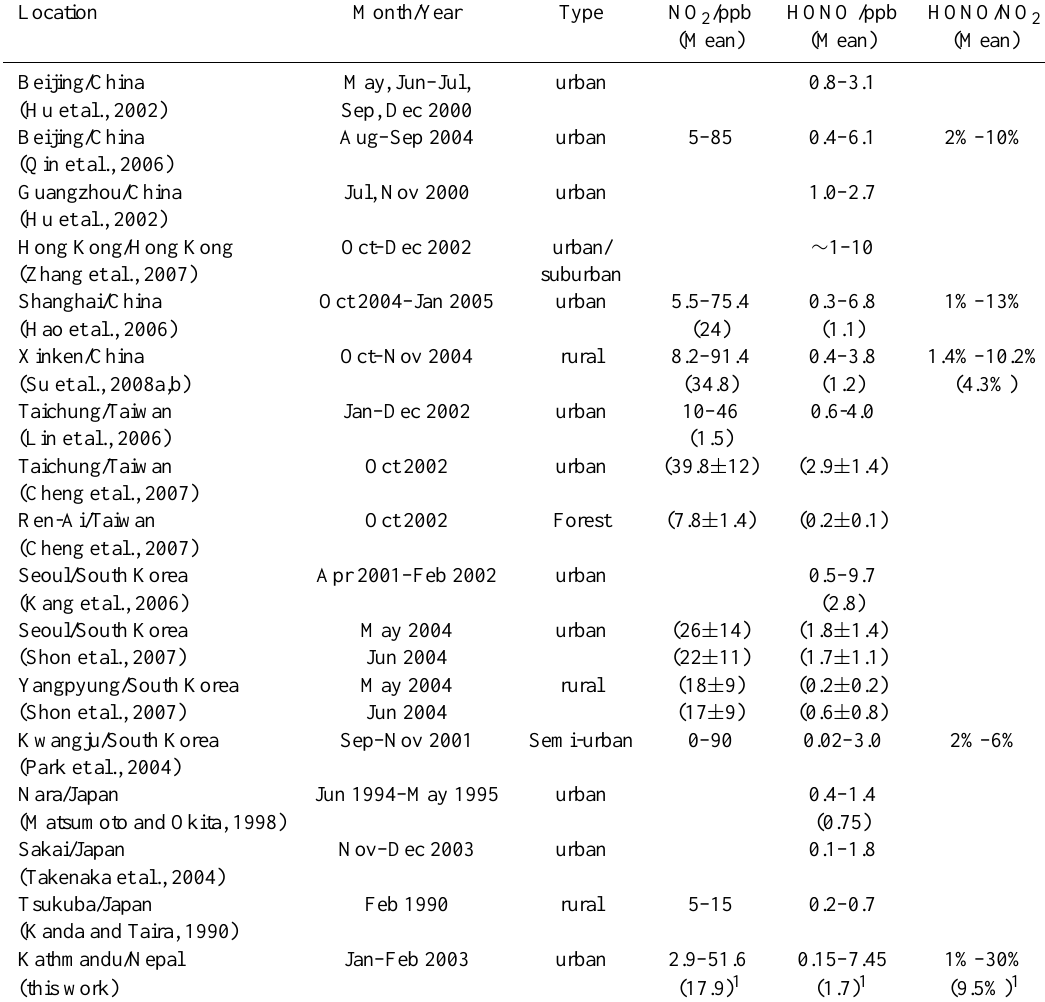
Table 1. HONO and NO 2 measurements in